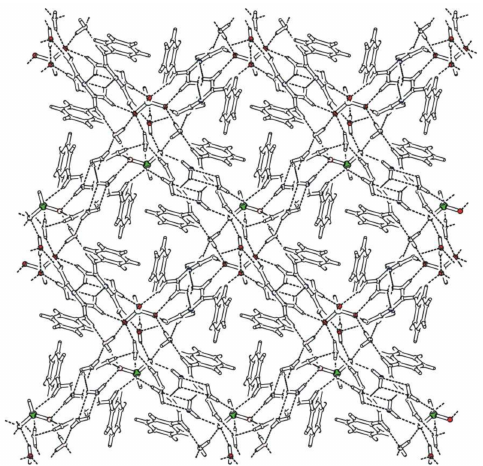
Figure 7. Packing scheme of phbigua 2 HPO 3 2H 2 O (view along the b axis direction); dashed lines indicate hydrogen